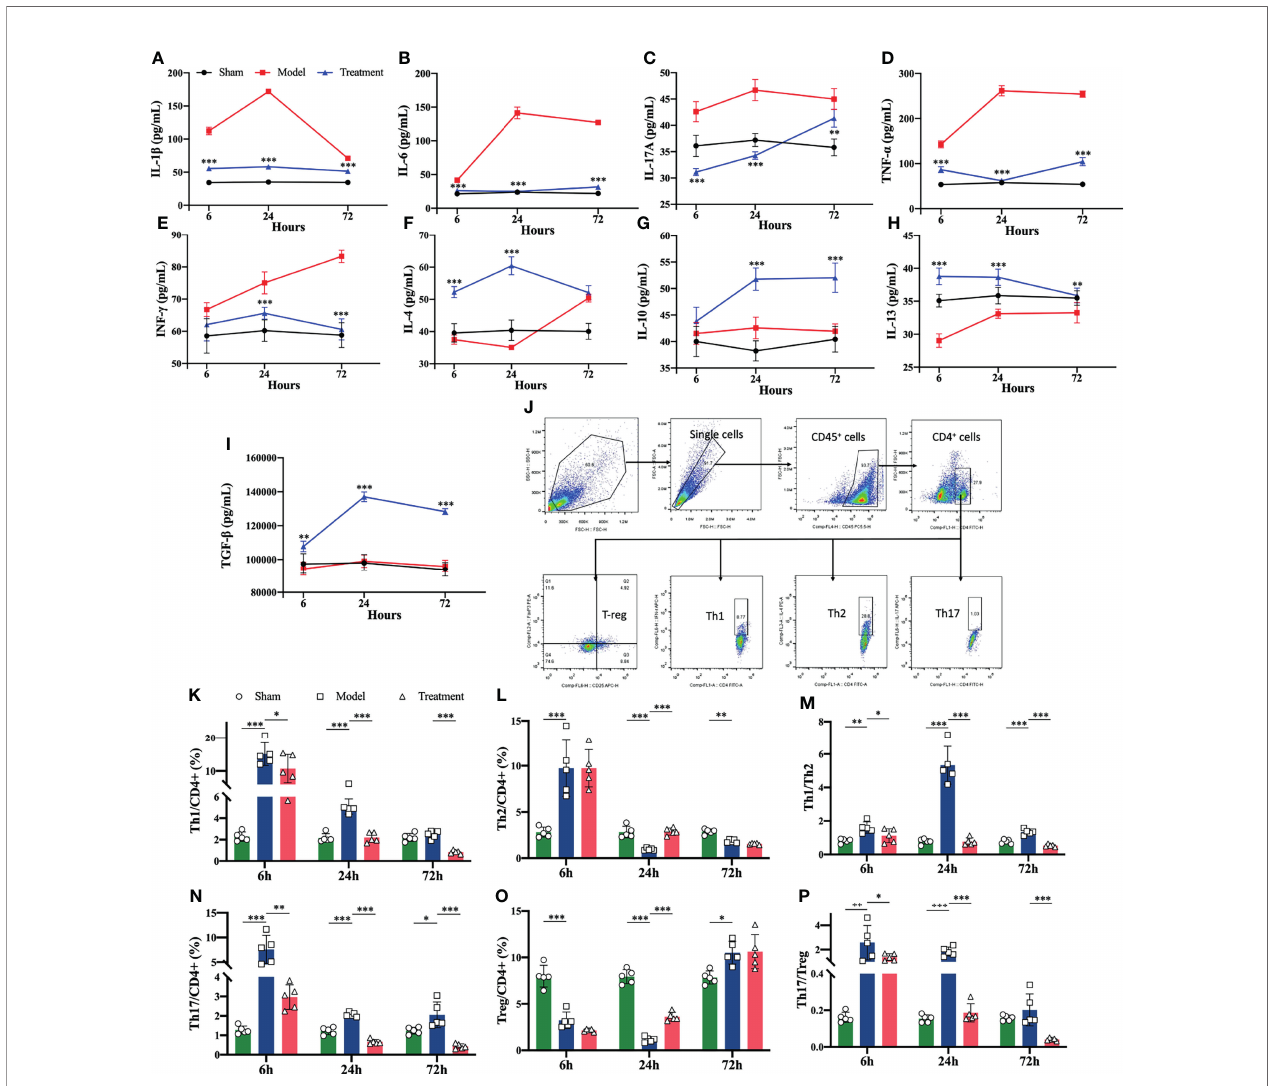
FIGURE 4 | Levels of in fl ammatory cytokines and proportions of Th cell subpopulations in the spleen suspensions of rats in each group. (A-I) Levels of in fl ammatory cytokines in the spleen suspensions of rats in each group (compared with the model group); (J) circle-gating strategy for fl ow cytometry analysis of the proportion of splenic Th cells; (K, L, N, O) fl ow analysis of the proportion of Th1, Th2, Th17, and Treg cells in the spleen as a percentage of CD4 + T cells; (M) the ratio of Th1/Th2 in the spleen of rats in each group; (P) the ratio of The ratio of Th17/Treg in spleen of each group. n=5, *p<0.05, **p<0.01,